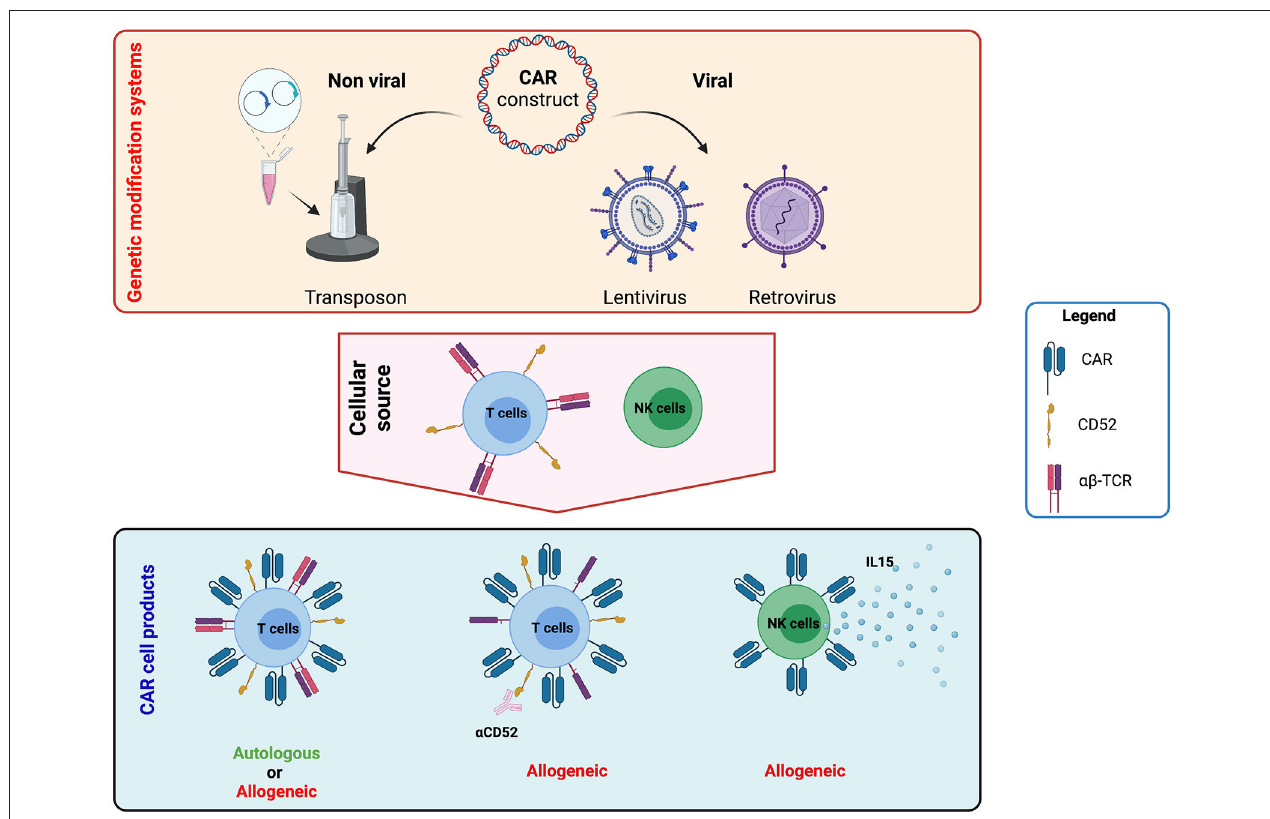
FIGURE 3 | Strategies to generate chimeric antigen receptor (CAR) T and natural killer (NK) cell products. CAR constructs can be generated using viral (lentivirus and retrovirus) and non-viral (transposon system) platforms. The construct can include other elements besides the CAR to increase long-term efficacy and clinical application. For example, it is possible to include the expression of cytokines such as interleukin (IL)-12, IL-15, or IL-18 to improve persistence or gene-editing tools to abrogate the expression of endogenous proteins like T-cell receptor (TCR) elements or CD52. These constructs can then be used to genetically modify either autologous and allogeneic T or NK cells. Image created with